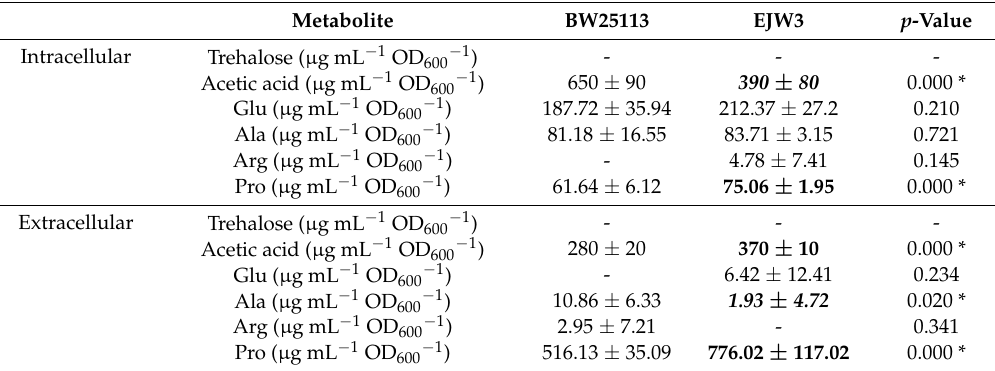
Table 4. Quantification of intracellular and extracellular metabolites in